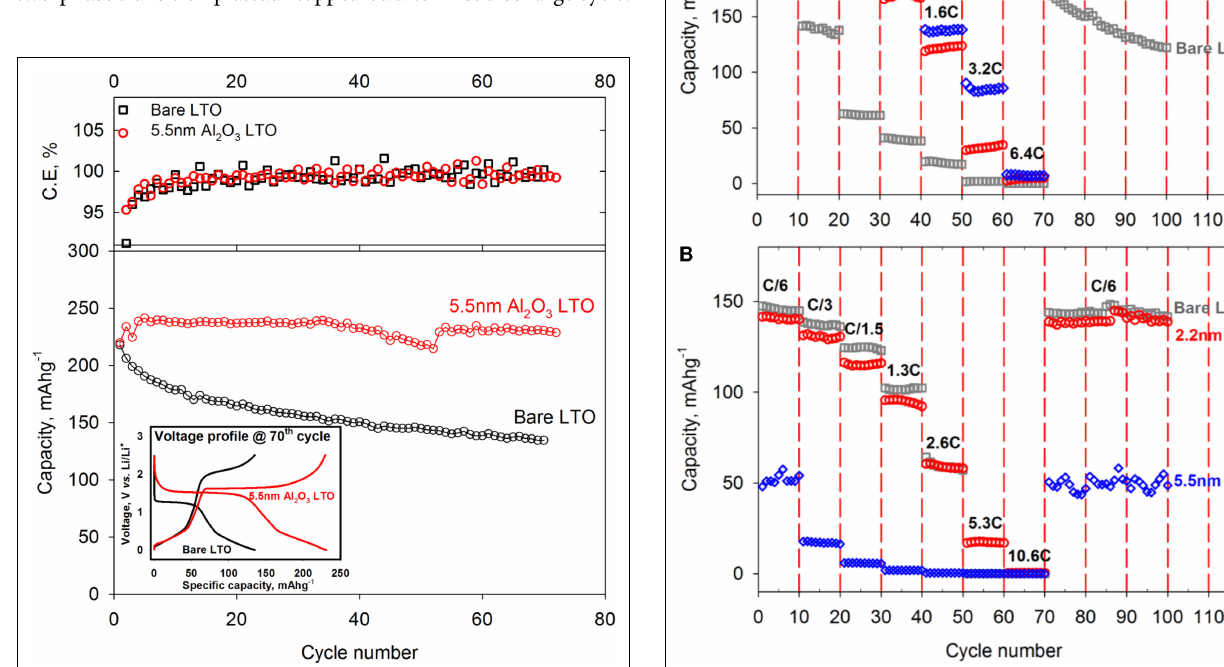
FIGURE 5 | Capacity retention and Coulombic efficiency of the pristine LTO (black) and 5.5nm Al 2 O 3 -coated LTO (red) electrode . Both charging and discharging current densities were 50mAg (cid:0) 1 and upper and lower cut-off potential were set as 2.5V and 1mV vs. Li/Li + , respectively. The inserted figure presented the voltage profile at 70th cycle both electrodes.